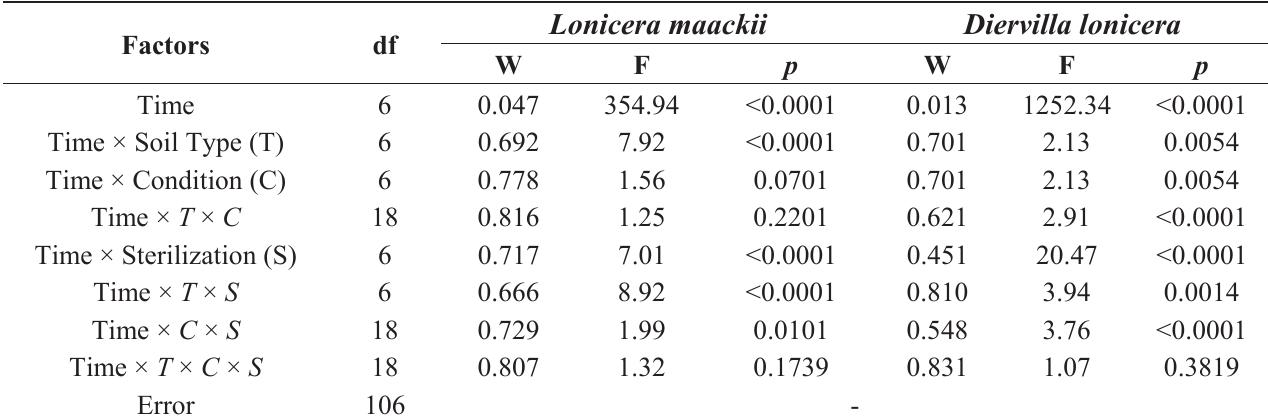
Table 3. Results of Repeated measures MANOVA with Wilks’ lambda test (W) for the effect of time and its interactions with soil type, soil conditioning, and soil sterilization on height of both species.